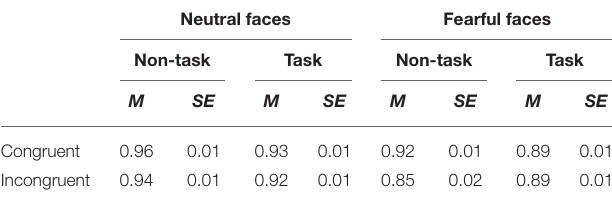
TABLE 3 | Mean of RTs (ms) and its SE for all the experimental conditions.